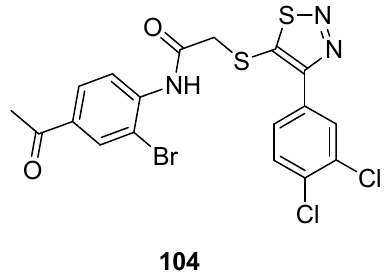
Figure 11. Antiviral activity of 4-(3,4-dichlorophenyl)-1,2,3-thiadiazole scaffold 104.